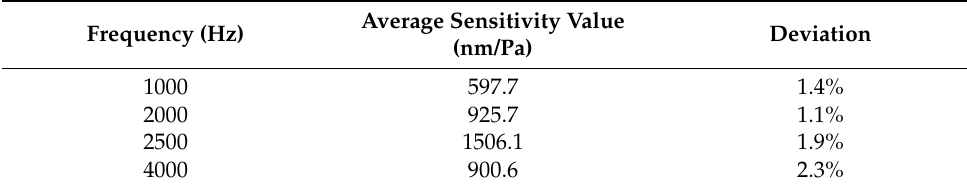
Figure 9. The long-term sensitivity of the FOM at different operating frequencies. Table 2. Long-term sensitivity analysis.